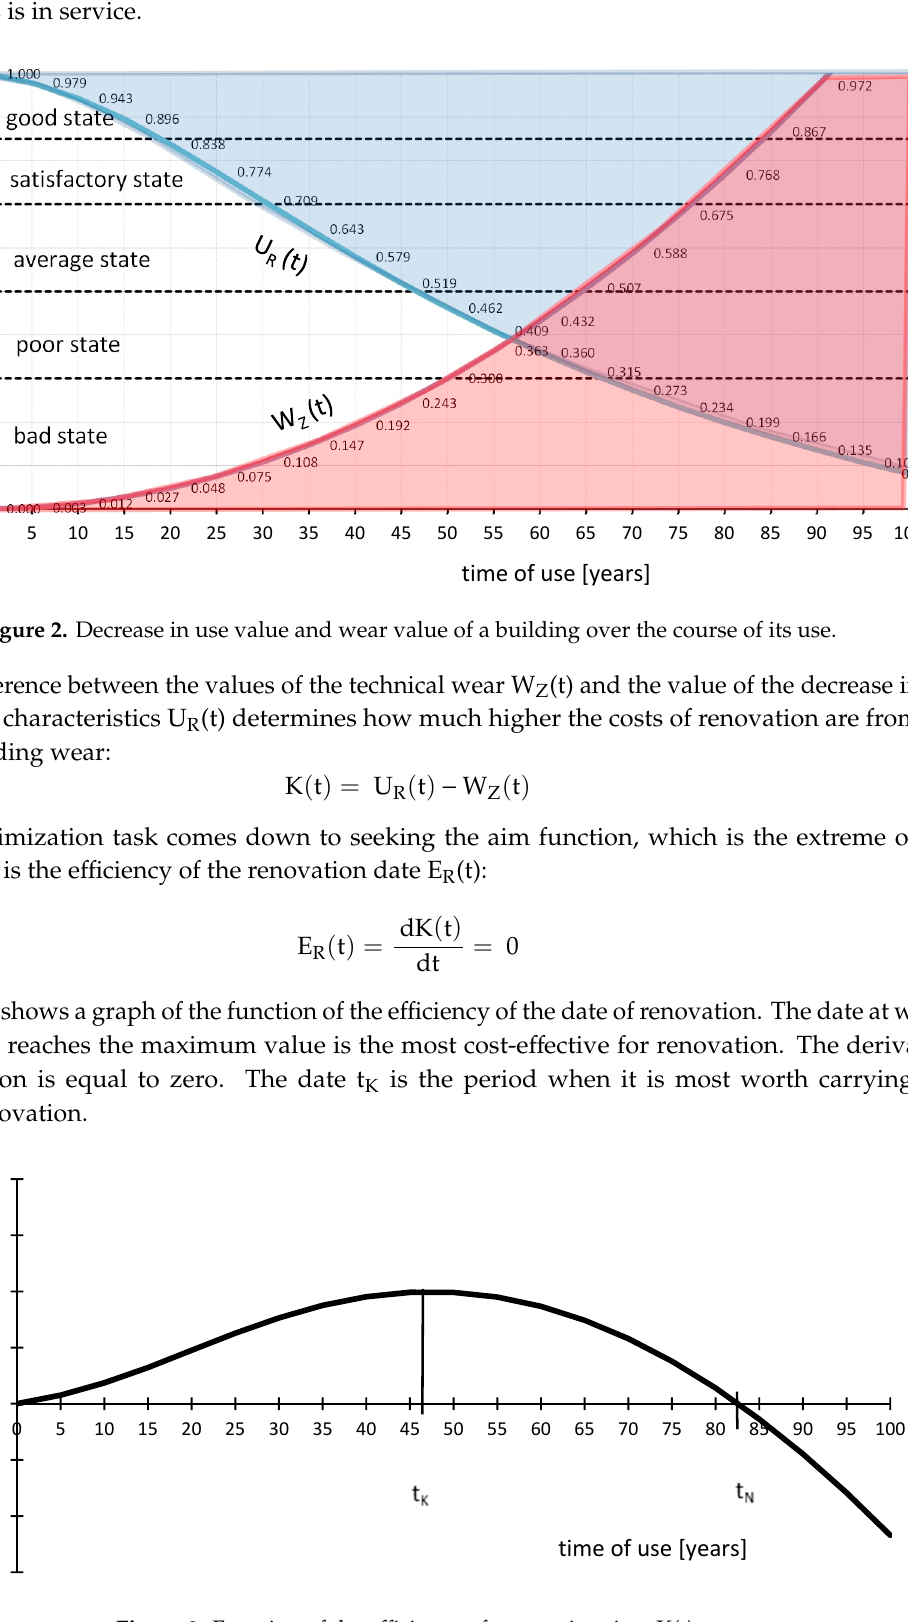
Figure 3. Function of the efficiency of renovation time K(t).